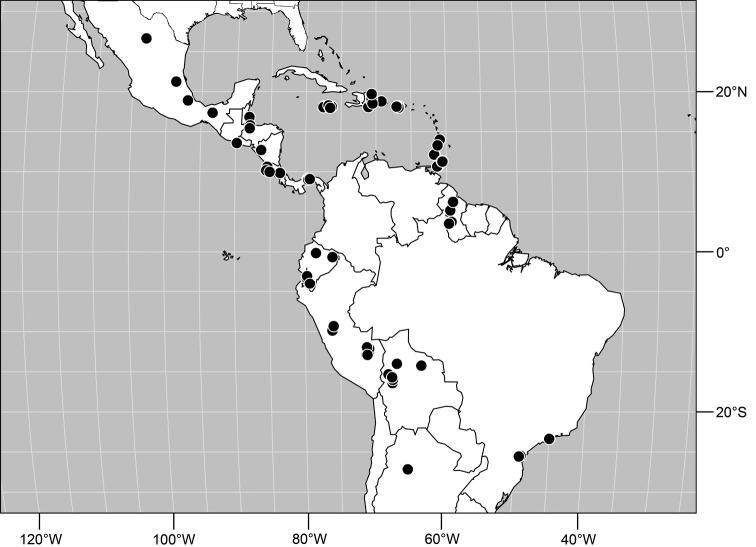
Distribution of Polytrichophora reginae Mathis.